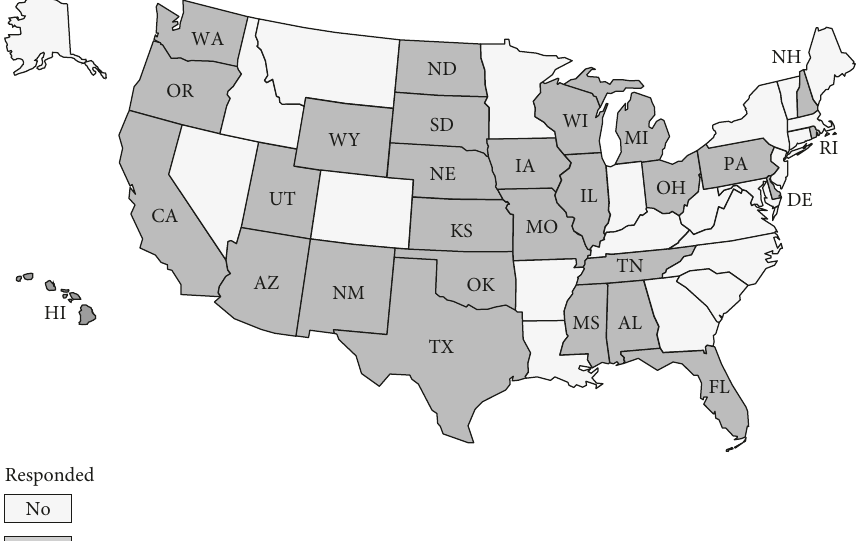
Figure 1: States who responded to demolition survey.